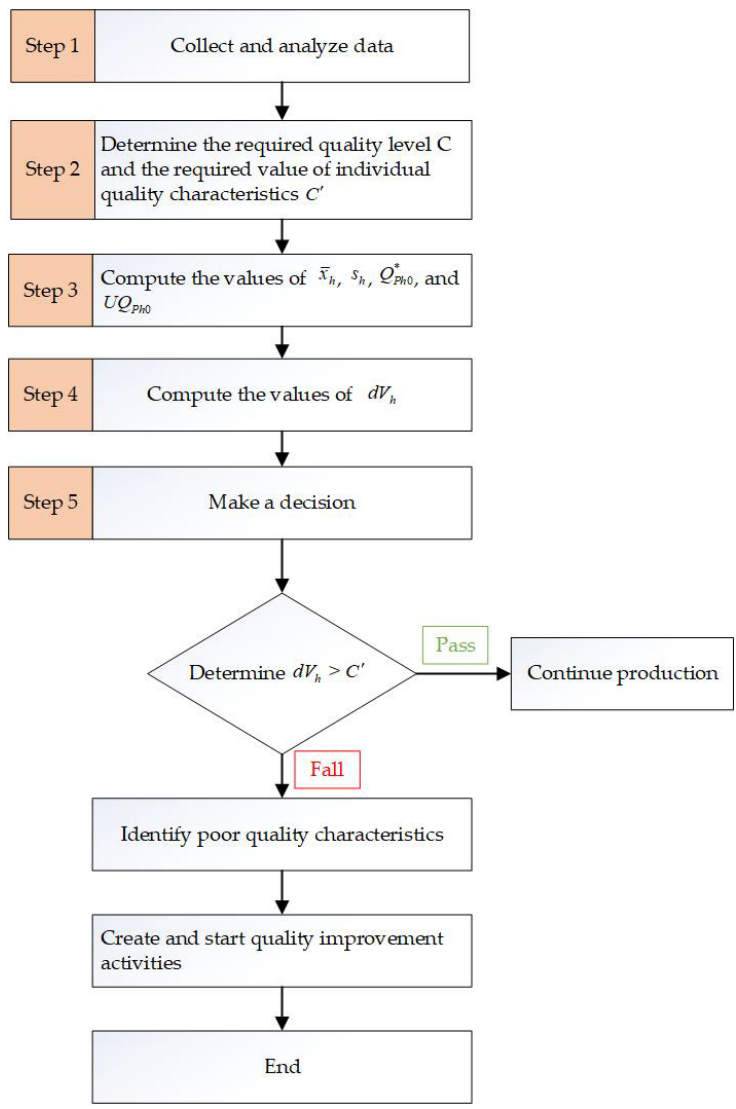
Figure 2. Flowchart of the proposed method.